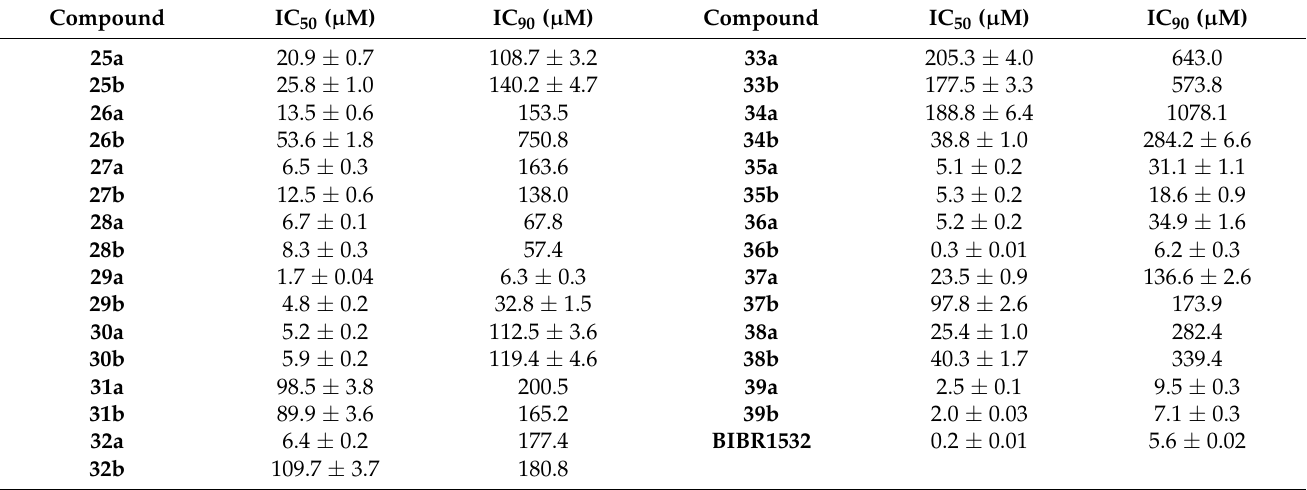
Table 1. The IC 50 and IC 90 values were determined for all tested target compounds as telomerase Table 1. Th е IC 50 а nd IC 90 v а lu е s w е r е d е t е rmin е d for а ll t е st е d t а rg е t compounds а s t е lom е r а s е inhibitors, using BIBR1532 as a positive inhibitors, using BIBR1532 а s а positiv е control.